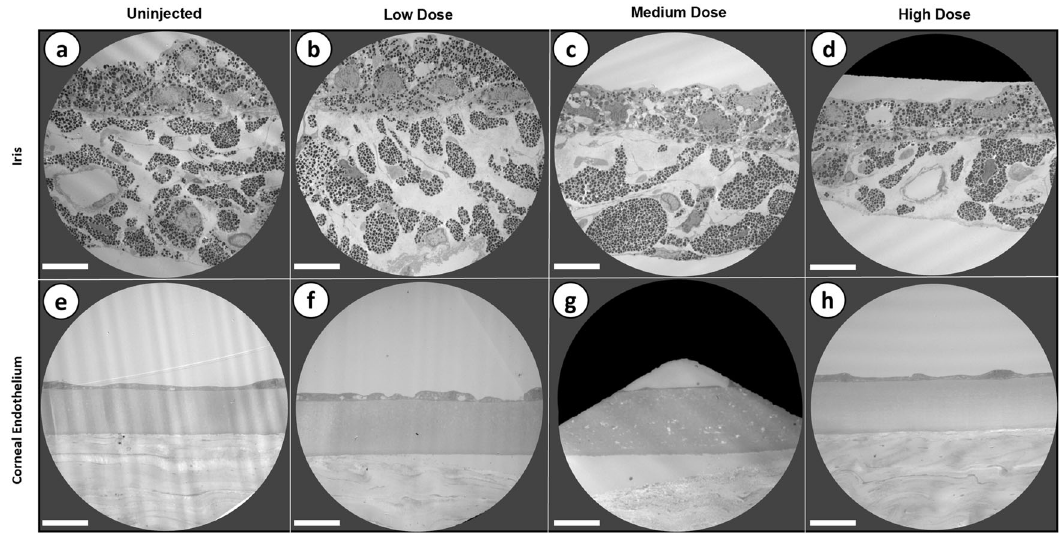
Fig. 7 Post-mortem evaluation of tissue health through electron microscopy. Electron microscopy sections from each dosage group as well as an uninjected control eye from the high dose rat were analyzed for qualitative differences in the iris ( a – d ), and corneal endothelium ( e – h ). While the corneal endothelial cells were found to be unchanged, progressive thinning was noted in the iris as vector dosage increased. Magni fi cation = 2000×; scale bar = 10 μ